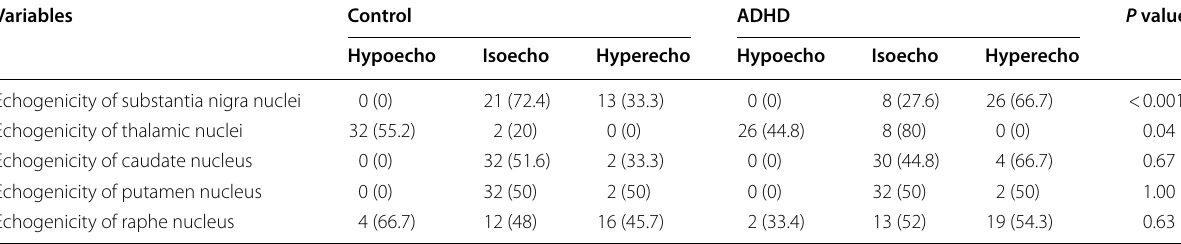
Table 2 Frequency (percentage) of echogenicity of different areas in patients participating in the study Variables